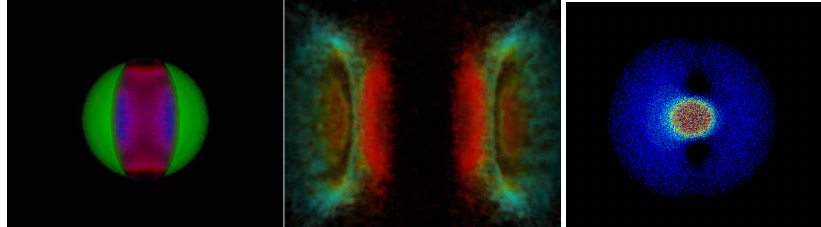
Figure 8. Examples of web-based visualizations in particle physics. Left: Chandler et al. [73] showing WebGL-based rendering of the gravity-free collision of two spherical fluid elements in two different time steps. Right: Visualization of the decay of hydrogen with the tool QMwebJS